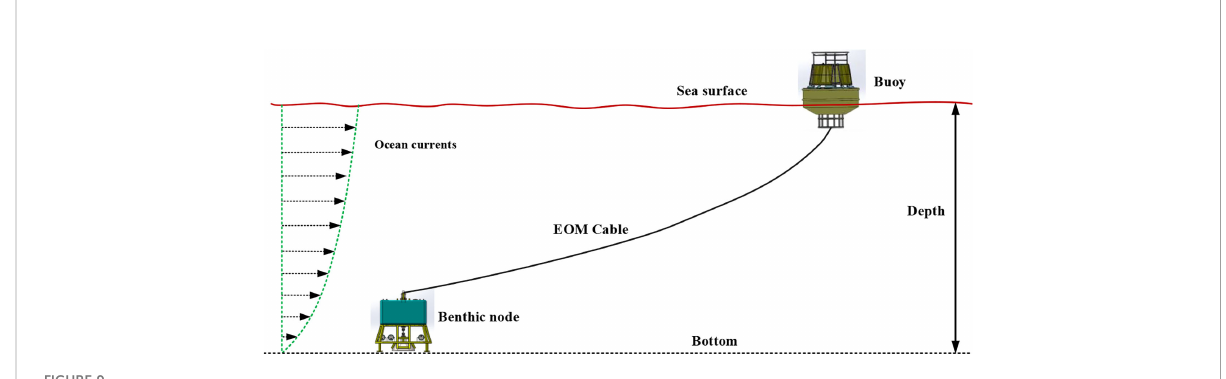
FIGURE 9 Mooring diagram of deployed